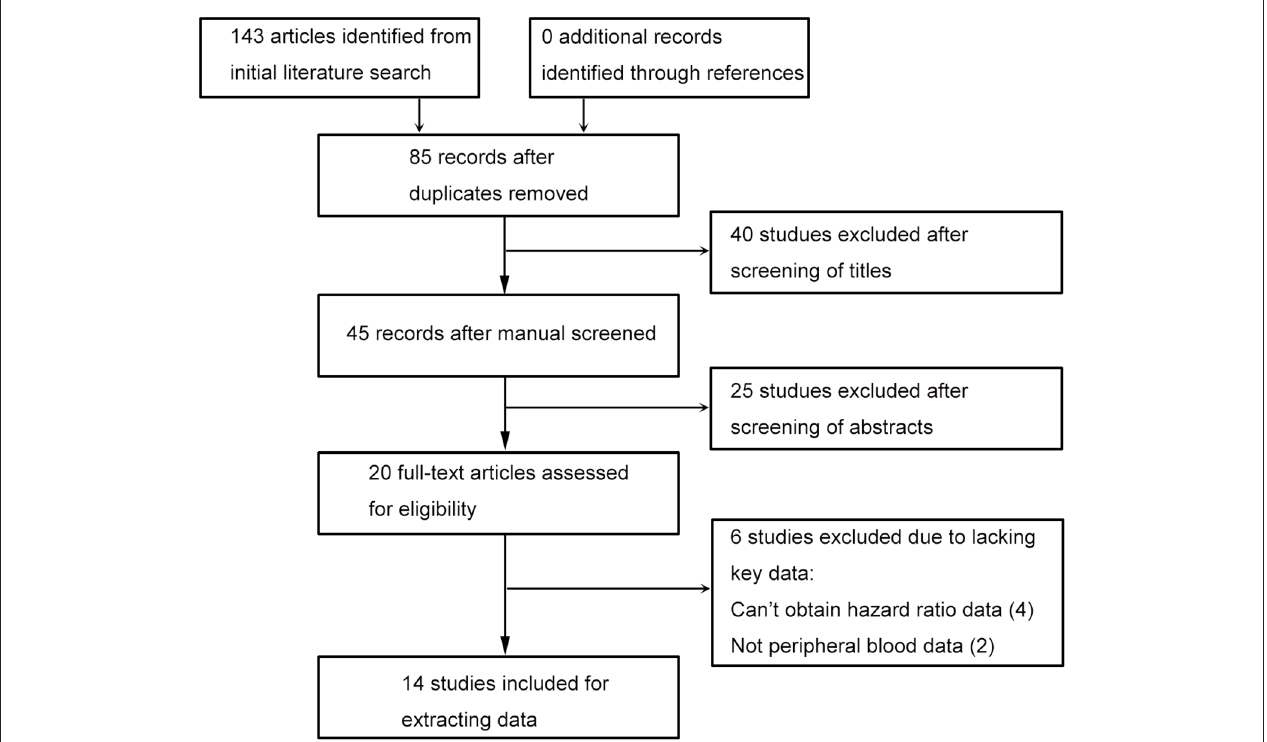
FIGURE 1 | Flowchart of study searching and